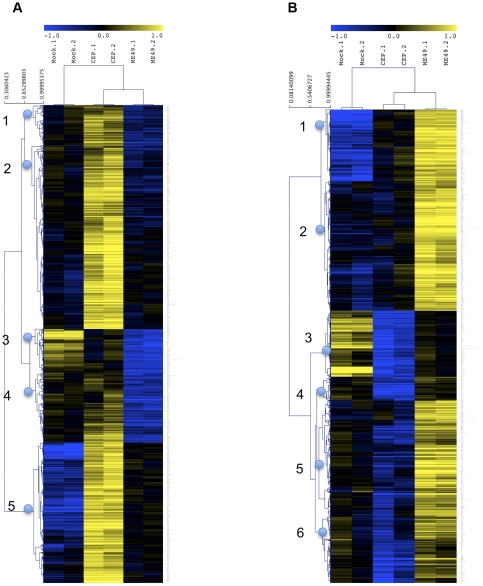
Type II and Type III strains induce distinct transcriptional programs in chicken embryonic fibroblasts.Microarray analysis of SL-29 chicken embryonic fibroblasts subjected to mock, Type II (ME49), or Type III (CEP) infection. 2 biological replicates were performed for each treatment and RNA was harvested at 24 hours post-infection. Genes shown are those identified as significantly up-regulated by SAM analysis (FDR<5% and fold change ≥1.5) either in Type III infection over Type II infection (A) or in Type II infection over Type III infection (B). For heatmap representation, probe intensities were log2-transformed and median centered by row; unsupervised hierarchical clustering was then performed (cluster numbers indicated on left). The color gradient key at top represents the color range in a log2 scale, from relative upregulation by 2-fold (yellow) and relative downregulation by 2-fold (blue).